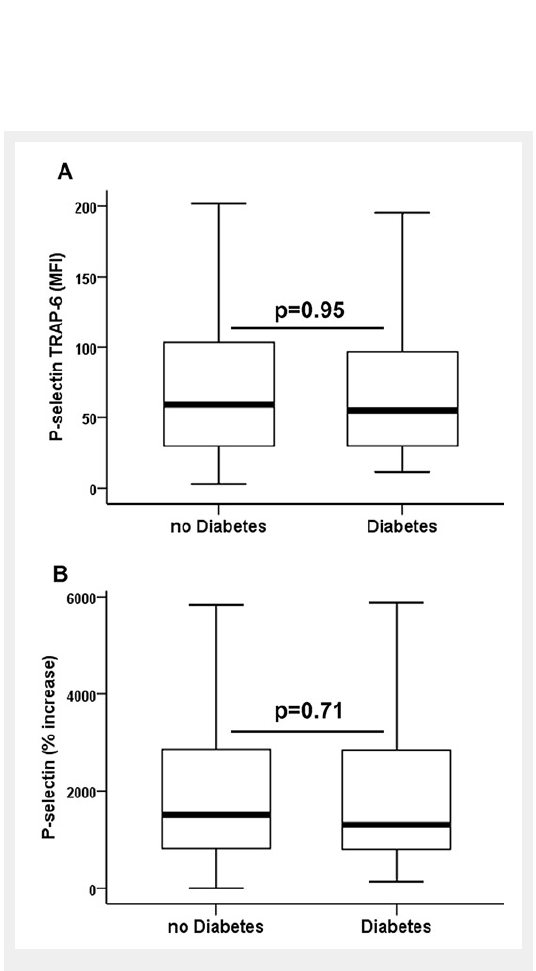
(A) Thrombin receptor activating peptide-6 (TRAP-6) inducible P- selectin (P-selectin TRAP-6) and (B) relative increase of platelet P- selectin (% increase) after activation with TRAP-6 in patients with peripheral artery or cerebrovascular disease without and with type 2 diabetes. The boundaries of the box show the lower and upper quartiles of data, the line inside the box represents the median. Whiskers are drawn from the edge of the box to the highest and lowest values that are outside the box but within 1.5 times the box length. MFI = mean fluorescence